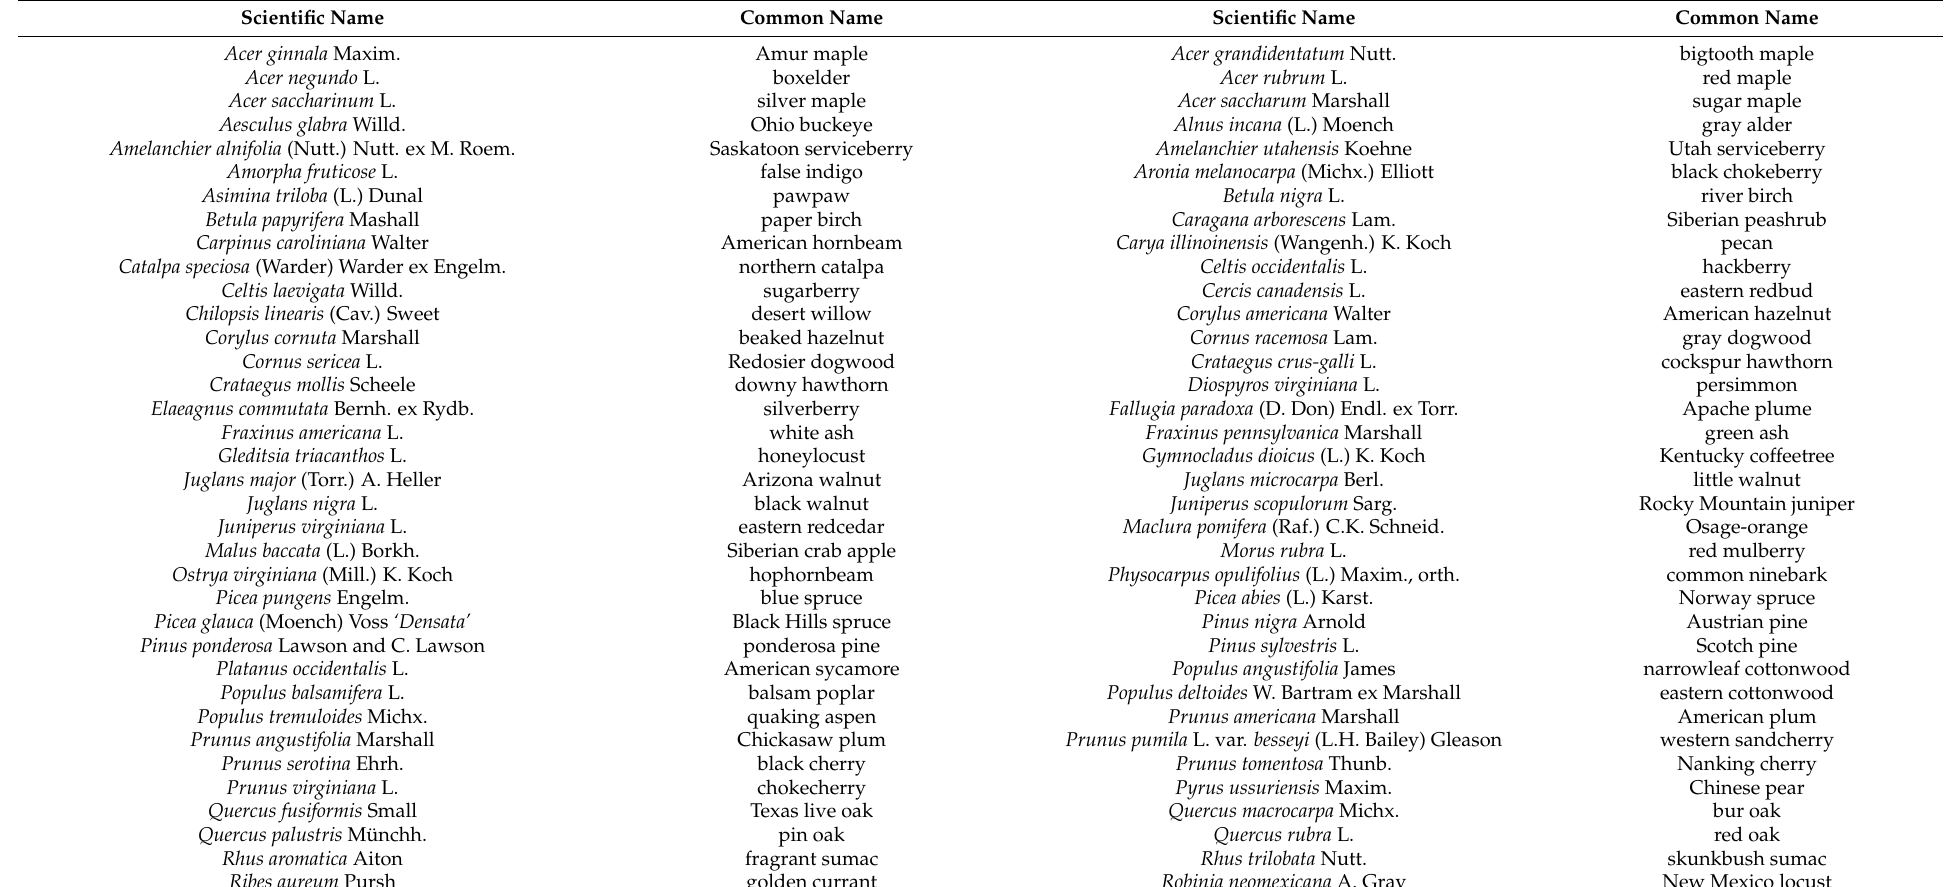
Table A1. Tree and shrub species used in Tree